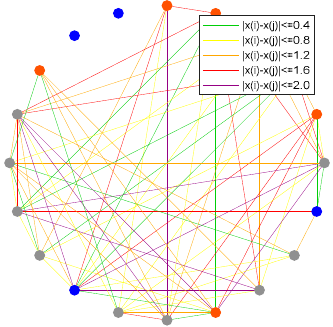
Int. J. Environ. Res. Public Health 2020 , 17 , 946 Figure 17. Connections among network nodes at the initial time and time = 10. Figure 17. Connections among network nodes at the initial time and time = 10. Figure 17. Connections among network nodes at the initial time and time = 10.